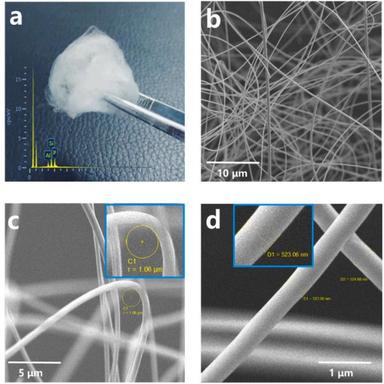
a–d Actual image and SEM images of nanofibers at different magnifications: (a) Digital photos of geopolymer nano-fibers and element distribution analyzed by energy dispersive spectrometer; (b) SEM images of nano-fibers; (c) Intriguing flexibility of nano-fibers which bent to a radius of about 1 μm; (d) diameter of nano-fibers.